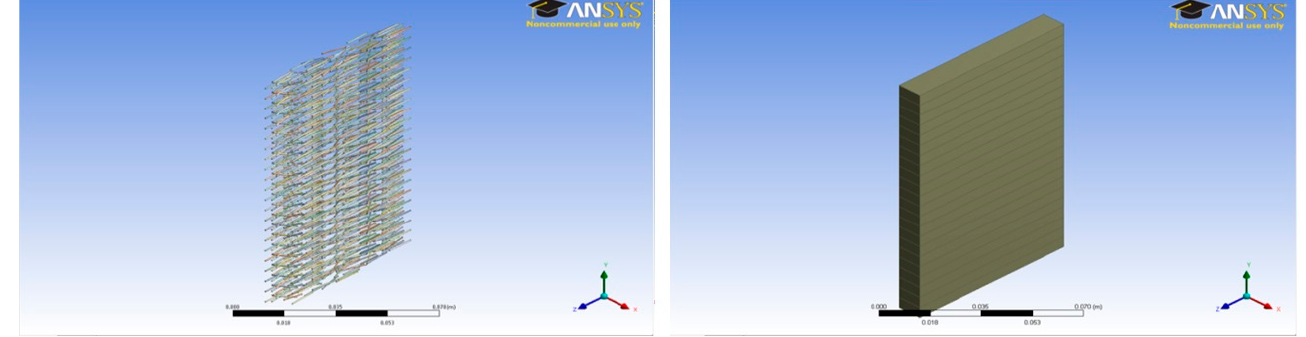
6 of 19 Figure 3. Plain concrete slab model (11 × 7 × 1 cm). Figure 4. One percent fiber sample model (11 × 7 × 1 cm) and concrete slab.